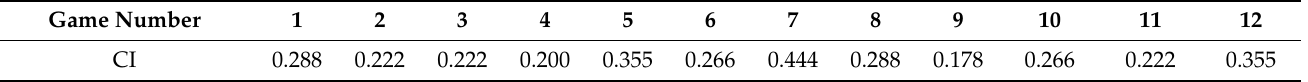
Table 2. Coordination Index (CI) values of the game boards in the experiment.